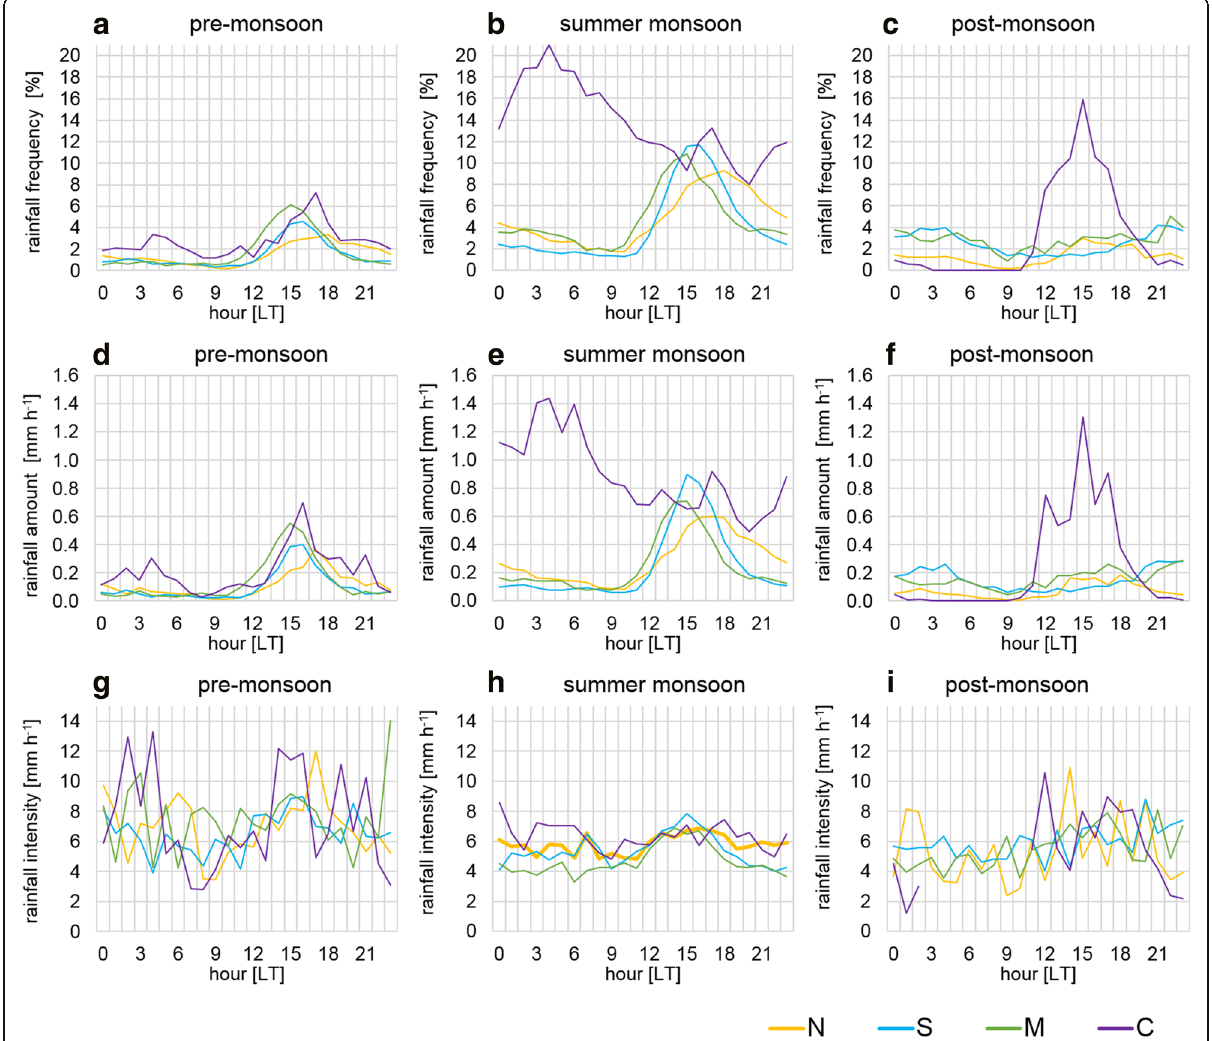
Fig. 5 Diurnal pattern of rainfall on rainfall frequency ( a – c ), rainfall amount ( d – f ), and rainfall intensity ( g – i ). The left panels ( a , d , g ) are for the pre-monsoon season, the middle panels ( b , e , h ) are for the summer monsoon season, and the right panels ( c , f , i ) are for the post-monsoon season. The values are the 6-year-averaged stats for regions N (yellow), S (blue), M (green), and C